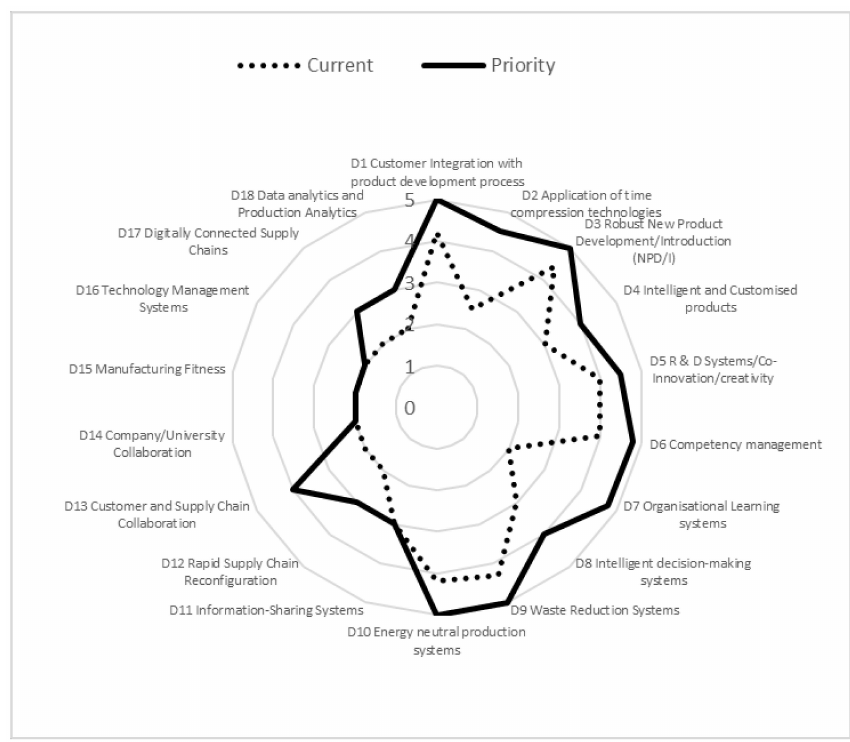
Figure 5. The analysis of current and future profiles of SMEs with 10–50 Employees—Food.